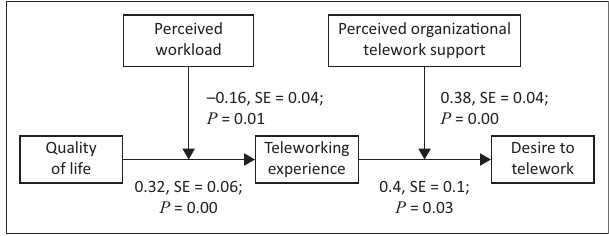
FIGURE 1: Hypothesised moderated mediation